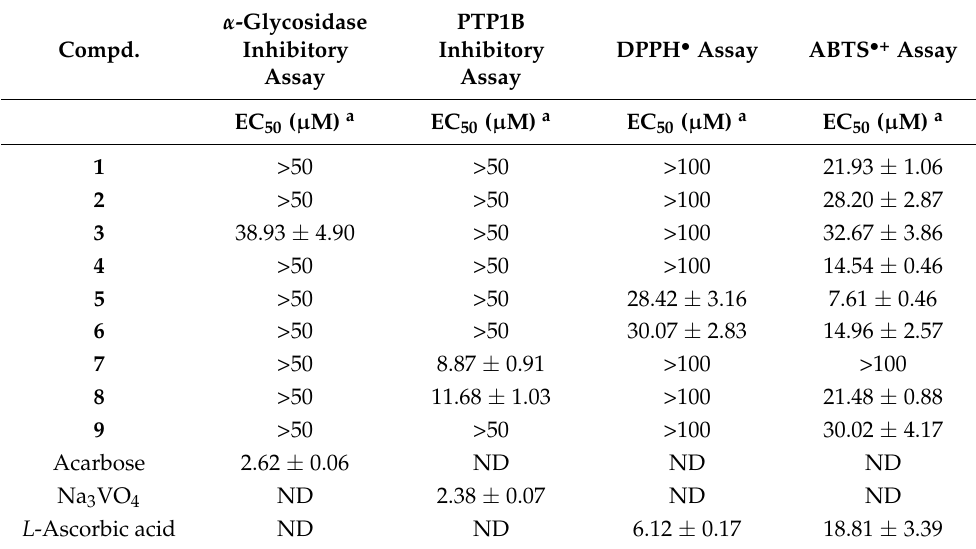
Table 2. Inhibitory activities on α -glycosidase and PTP1B together with antioxidant activity of compounds 1 – 9